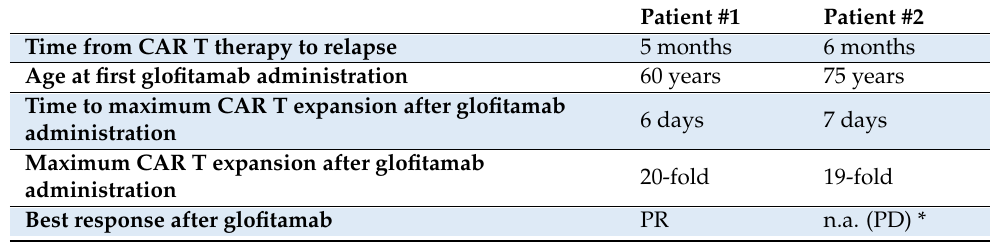
Table 2. Summary of patient characteristics and disease course after CAR T therapy and response to glofitamab therapy. * The second patient declined further therapy with glofitamab before response assessment and succumbed to disease